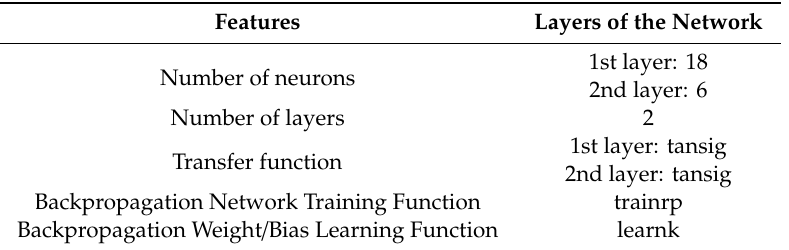
Table 1. Structure of hidden layers of the neural network used to select key